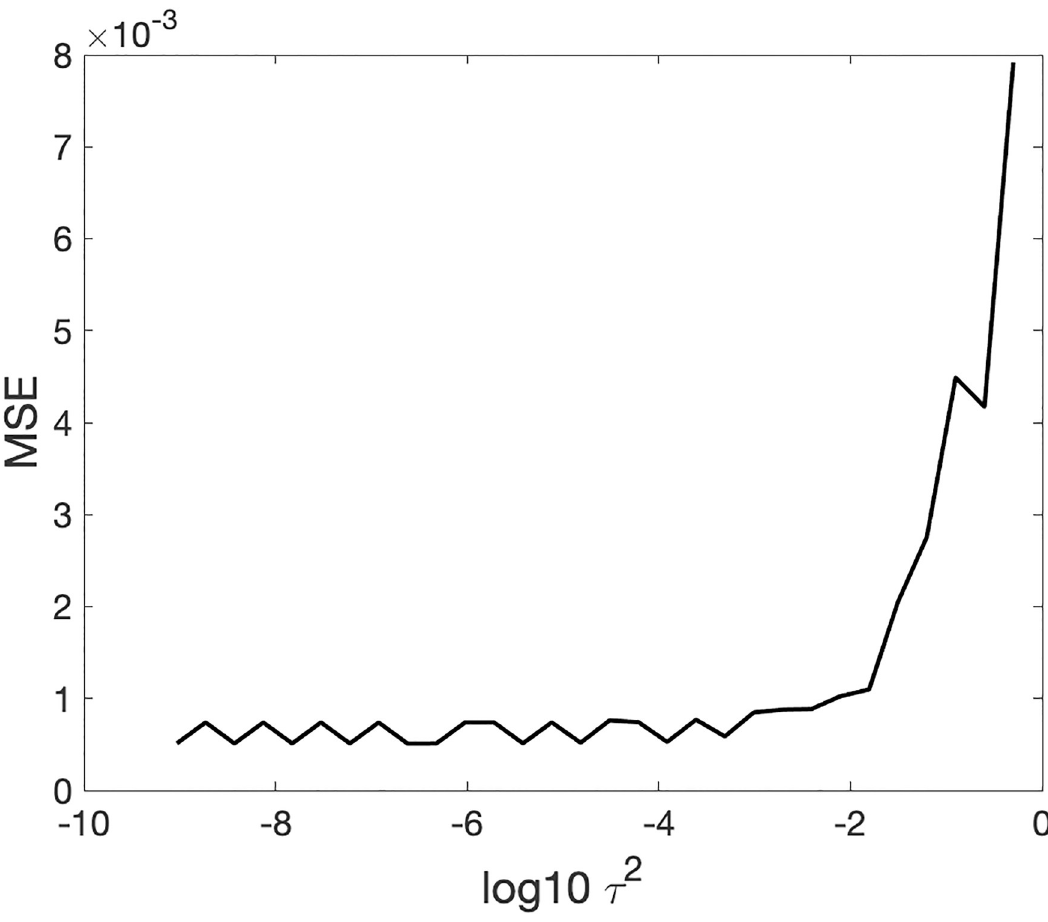
Fig 6. Noise sensitivity of